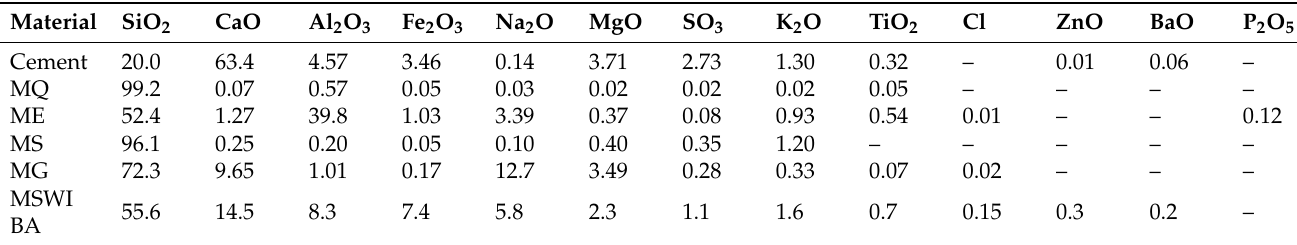
Table 1. Chemical compositions of materials